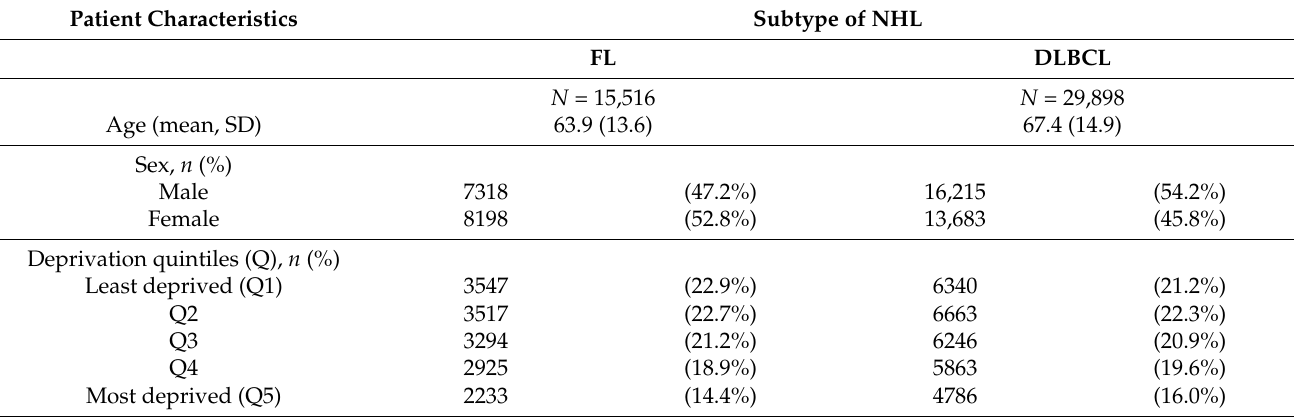
Table 1. Distribution of cancer subtypes by patient and healthcare system characteristics for patients ( n = 45,414) diagnosed with non-Hodgkin lymphoma in England during the period